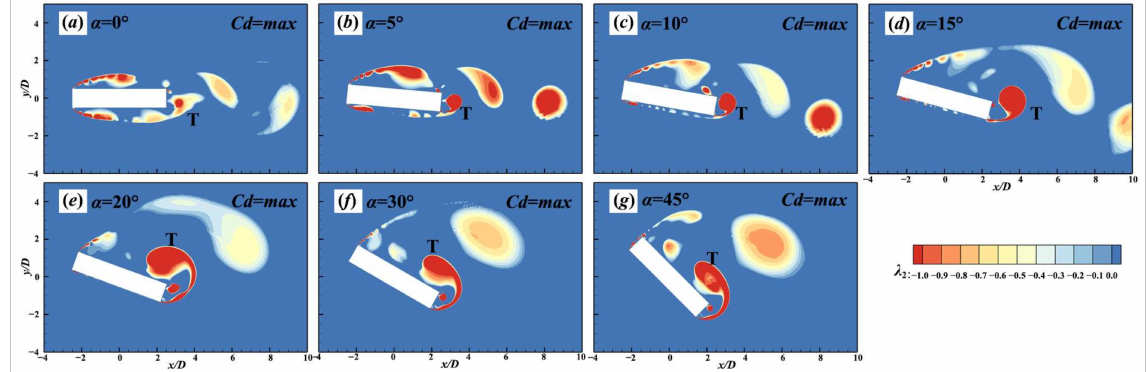
Figure 10. Instantaneous vortex structure with maximum drag coefficient at various AoAs. ( a ) α = 0 ◦ , ( b ) α = 5 ◦ , ( c ) α = 10 ◦ , ( d ) α = 15 ◦ , ( e ) α = 20 ◦ , ( f ) α = 30 ◦ , ( g ) α = 45 ◦